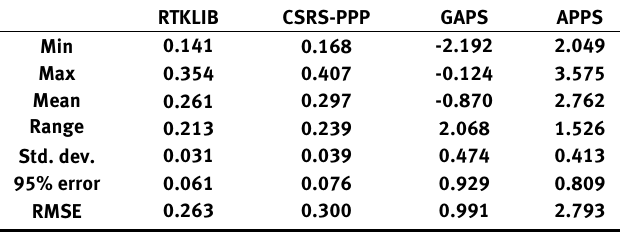
Table 4. Results for 1D displacements (Agisoft) (m).